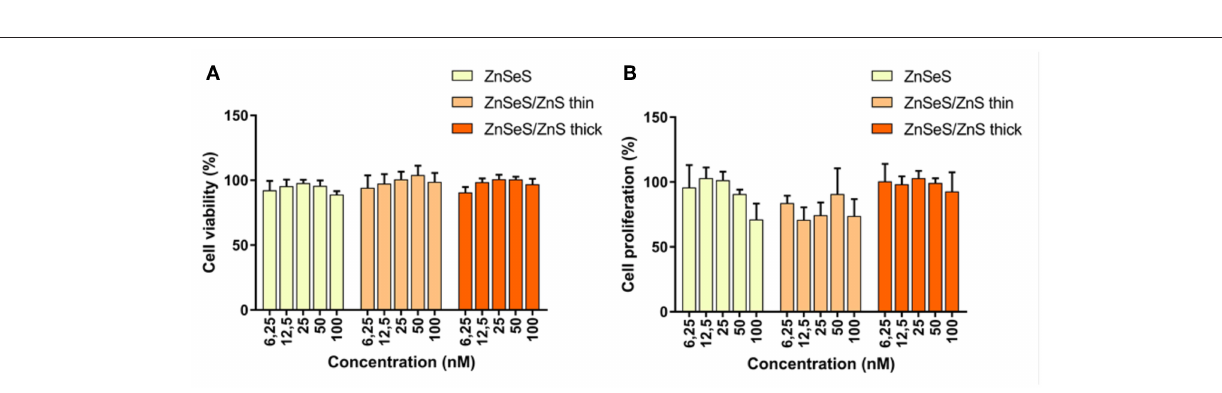
FIGURE 10 | Cell viability (A) and cell proliferation (B) of human keratinocytes exposed to increasing concentrations of QDs with different